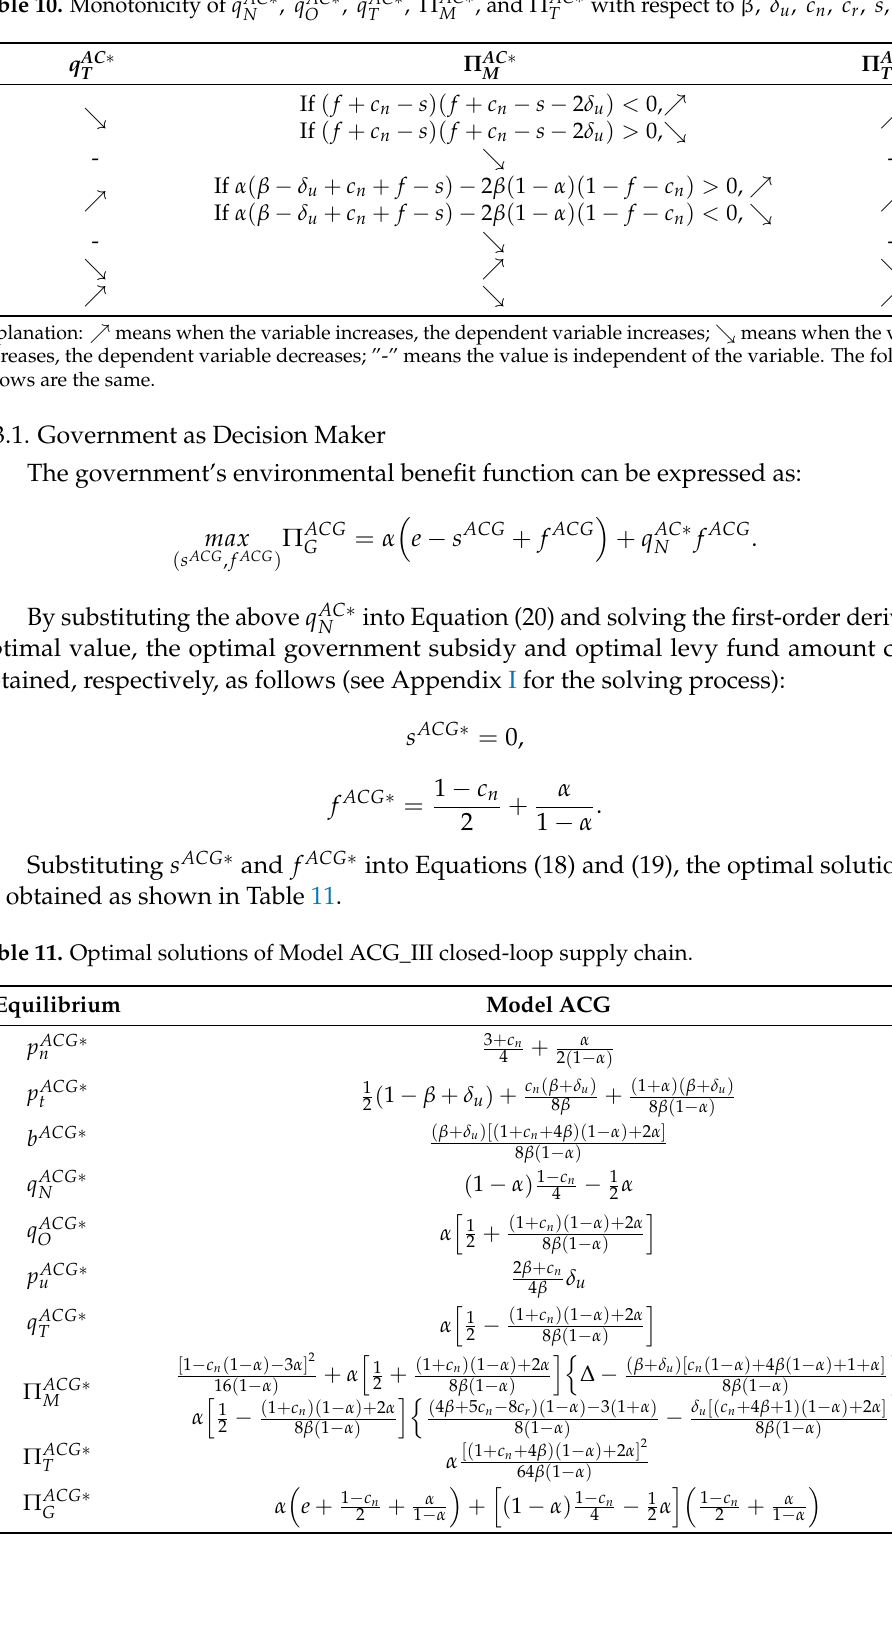
Table 10. Monotonicity of q AC ∗